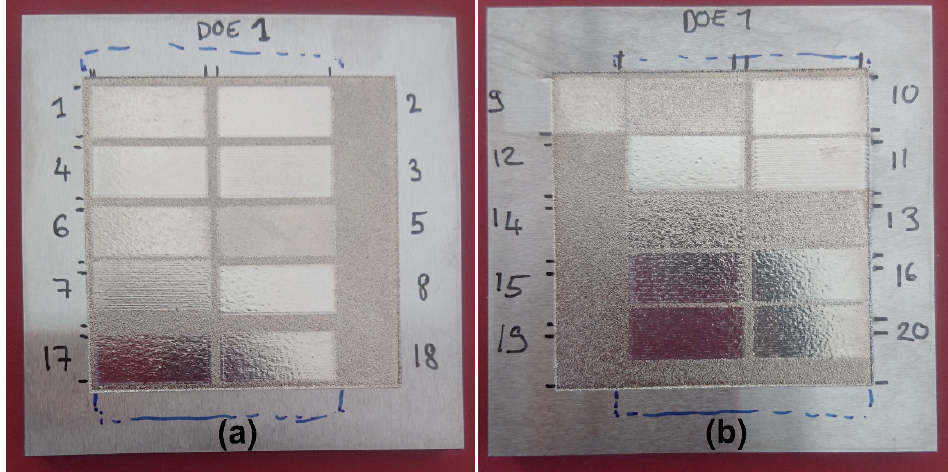
Figure 4. Pictures of the DoE surfaces after LP for a spot size of ( a ) 0.6 mm and ( b ) 0.9 mm. A proper statistical analysis of the DoE values obtained for the line roughness Ra revealed the effects of the parameters and interactions and they are given in Figure 5 and Equation (3). This analysis of the parameters shows that three main parameters; the velocity ( v = +0.25), temperature ( T = − 0.20) and overlap ( O = − 0.14) have the biggest influence